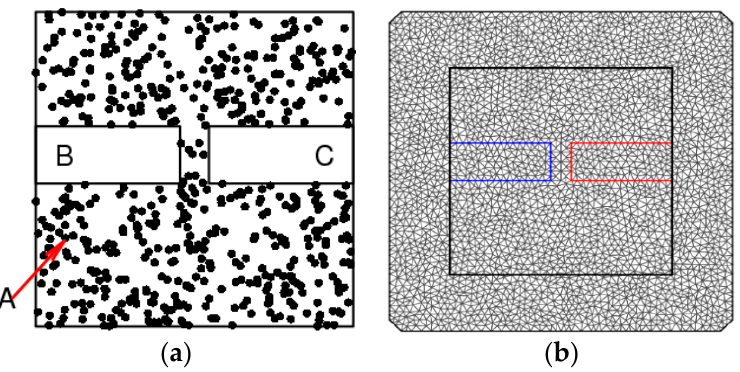
Figure 3. Simulation scenario: ( a ) Research area and data; ( b ) Triangular grid. Note: Area A in ( a ) represents the general area of interest, and areas B and C are two different types of obstacles.